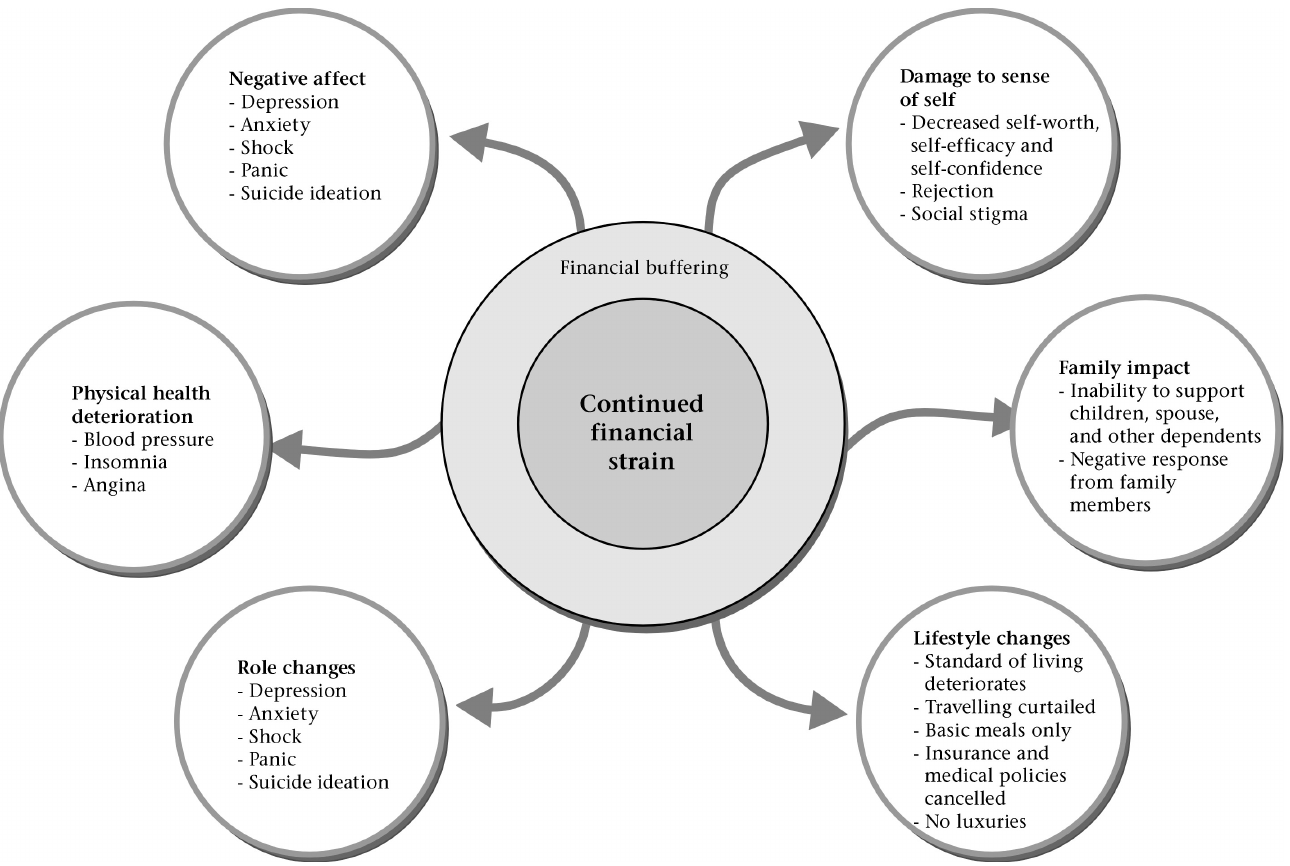
Figure 1:. Impact of Continued Financial Strain on the Unemployed